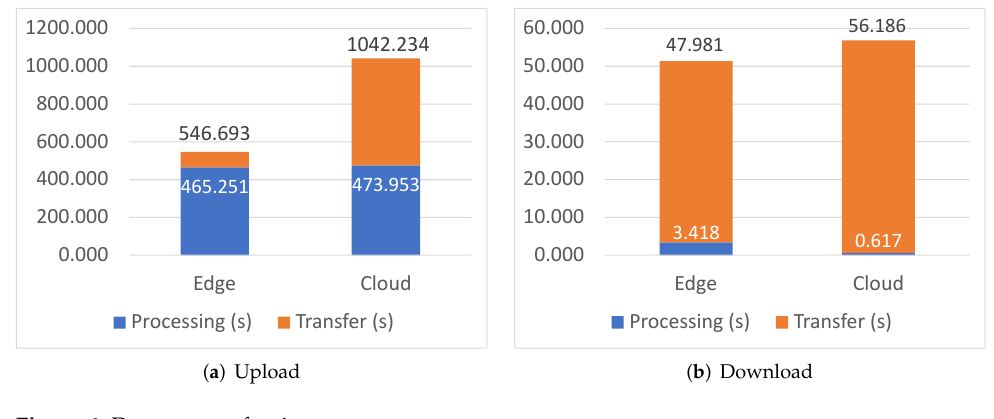
Figure 6. Dataset transfer